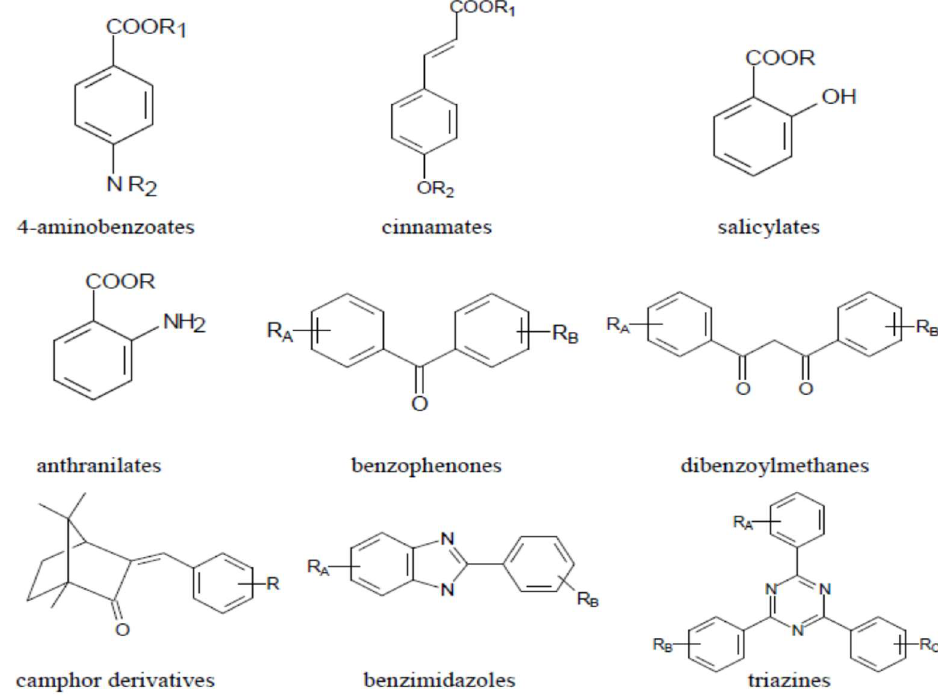
Figure 1. General structures of the most important currently-approved organic filters.